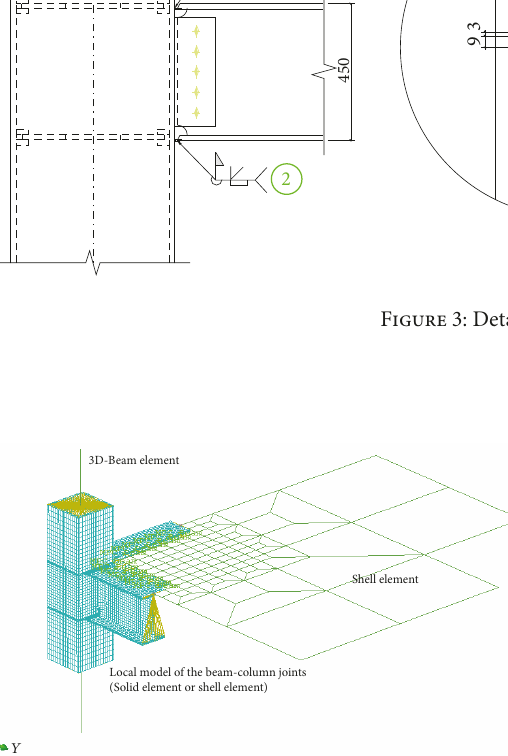
Figure 4: Multiscale FE model of the beam-to-column welded connection.